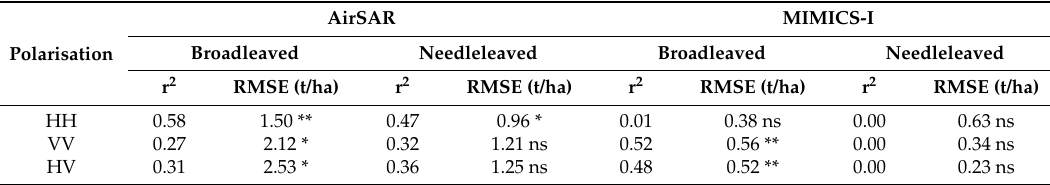
Figure 3. Observed (no fill) against Simulated (filled) backscatter for S-band as a function of varying forest AGB for ( a ) broadleaved and ( b ) needleleaved stands at different polarisations at 30 ◦ incidence angle. Best fit log relationships were fitted for ( a , b ). Table 5. Results of biomass regression models using S-band backscatter. r 2 is the coefficient of determination and RMSE is the root mean square error (t/ha) calculated using 17 broadleaved and 8 needleleaved plots.